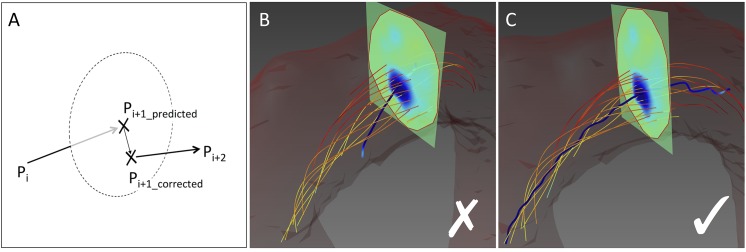
3D Vortex Core Detection.(A) Self-correcting approach of the vortex core identification algorithm. (B) An algorithm simply applying a streamline analysis to the vorticity field does not find the correct vortex core due to noise in the underlying MR velocity data. (C) With the predictor-corrector method, the core line is re-adjusted in every correction step so that single noisy data points do not compromise the rest of the vortex core identification process.